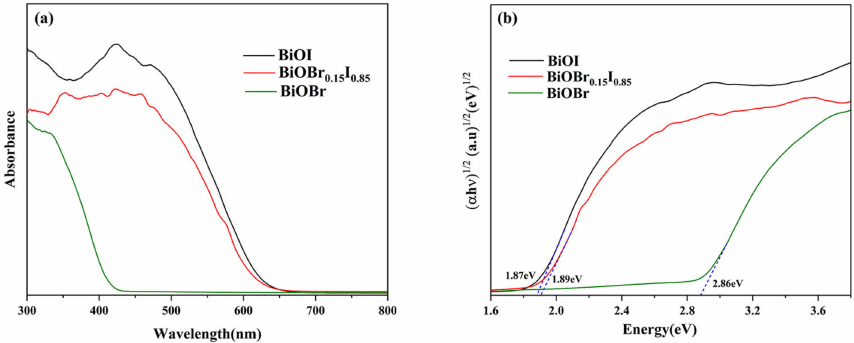
Figure 7. ( a ) UV-vis DRS, and ( b ) the Eg of BiOBr X I 1 − X (x = 0.00, 0.15, 1.00) photocatalysts. The photocatalytic activity of BiOBr X I 1 − X (x = 0.00, 0.05, 0.10, 0.15, 0.20) was evaluated by degrading rhodamine B under Xenon lamp irradiation ( λ > 400 nm). Due to the interaction between the electronegative (001) surface exposed by the BiOI photocatalyst and the positively charged cationic dye RhB, the photocatalysts had physical adsorption of RhB within 30 min of dark treatment (Figure 8). It should be noted that the material reached adsorption–desorption dynamic equilibrium (ratio of 1) after dark treatment for 30 min. The degradation rate of RhB was faster under 30 min of light, and then slowed down, accompanied by an obvious “blue shift” of the characteristic peak, indicating that RhB was deethylated to form